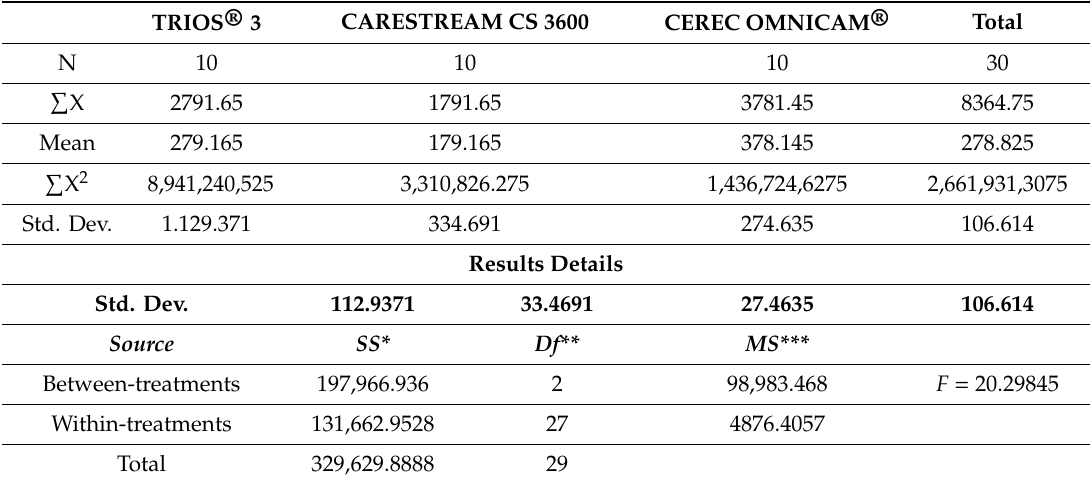
Table 3. Distance between reference lines and test ones in sample 2 with